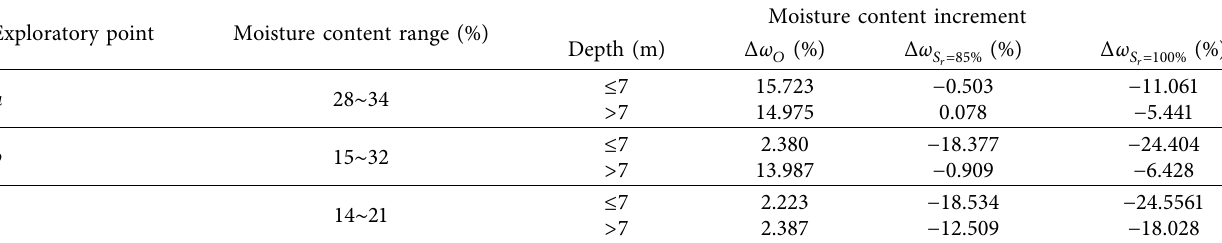
Figure 11: Comparison of moisture contents. Table 3: Average differences in moisture